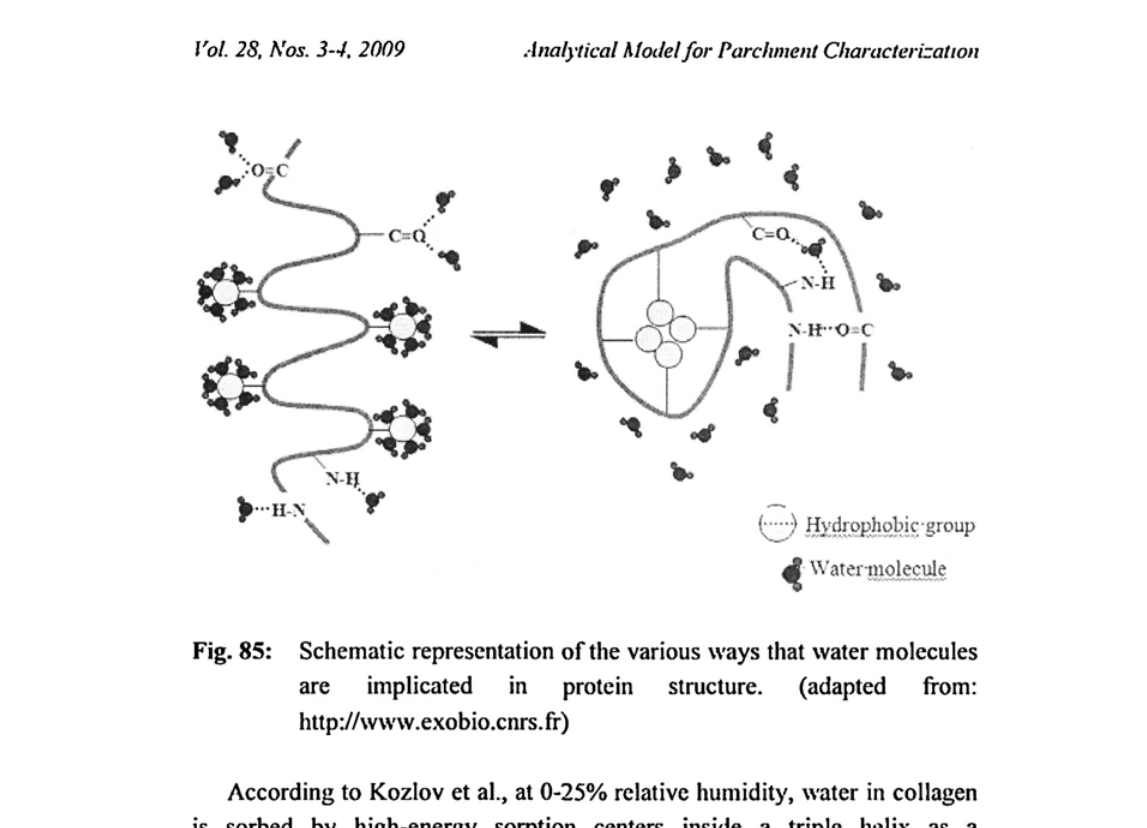
Fig. 85: Schematic representation of the various ways that water molecules are implicated in protein structure. (adapted from: http://www.exobio.cnrs.fr) According to Kozlov et al., at 0-25% relative humidity, water in